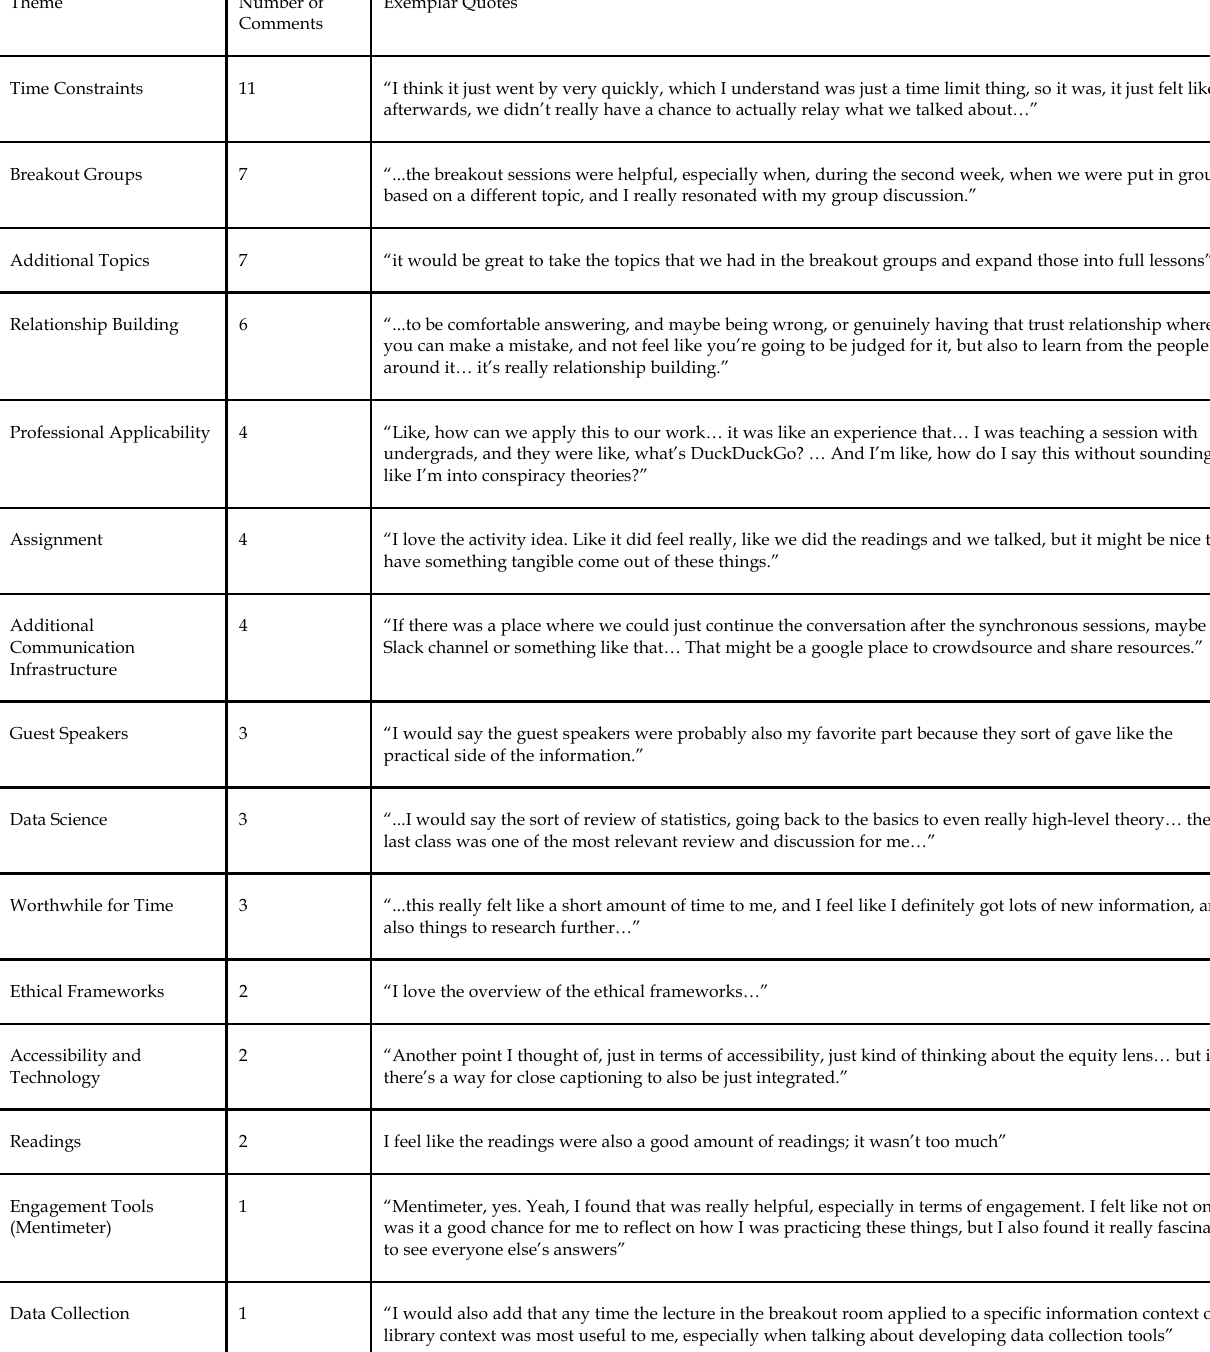
Table 3 Themes Identified, Number Coded, and Exemplary Quotes Theme Number of